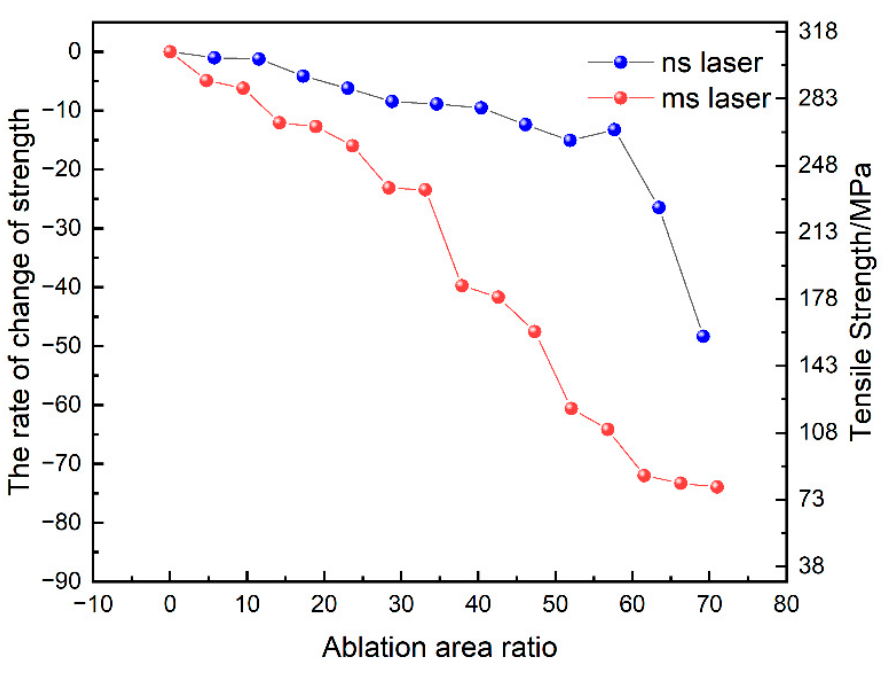
Figure 2. Variation of the rate of change of strength and tensile strength with the ablation area ratio for nanosecond and millisecond laser ablation of aluminum alloys.